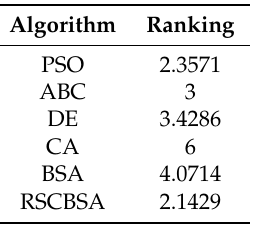
Table 2. Average Rankings of the algorithms (Friedman) on unimodal benchmark